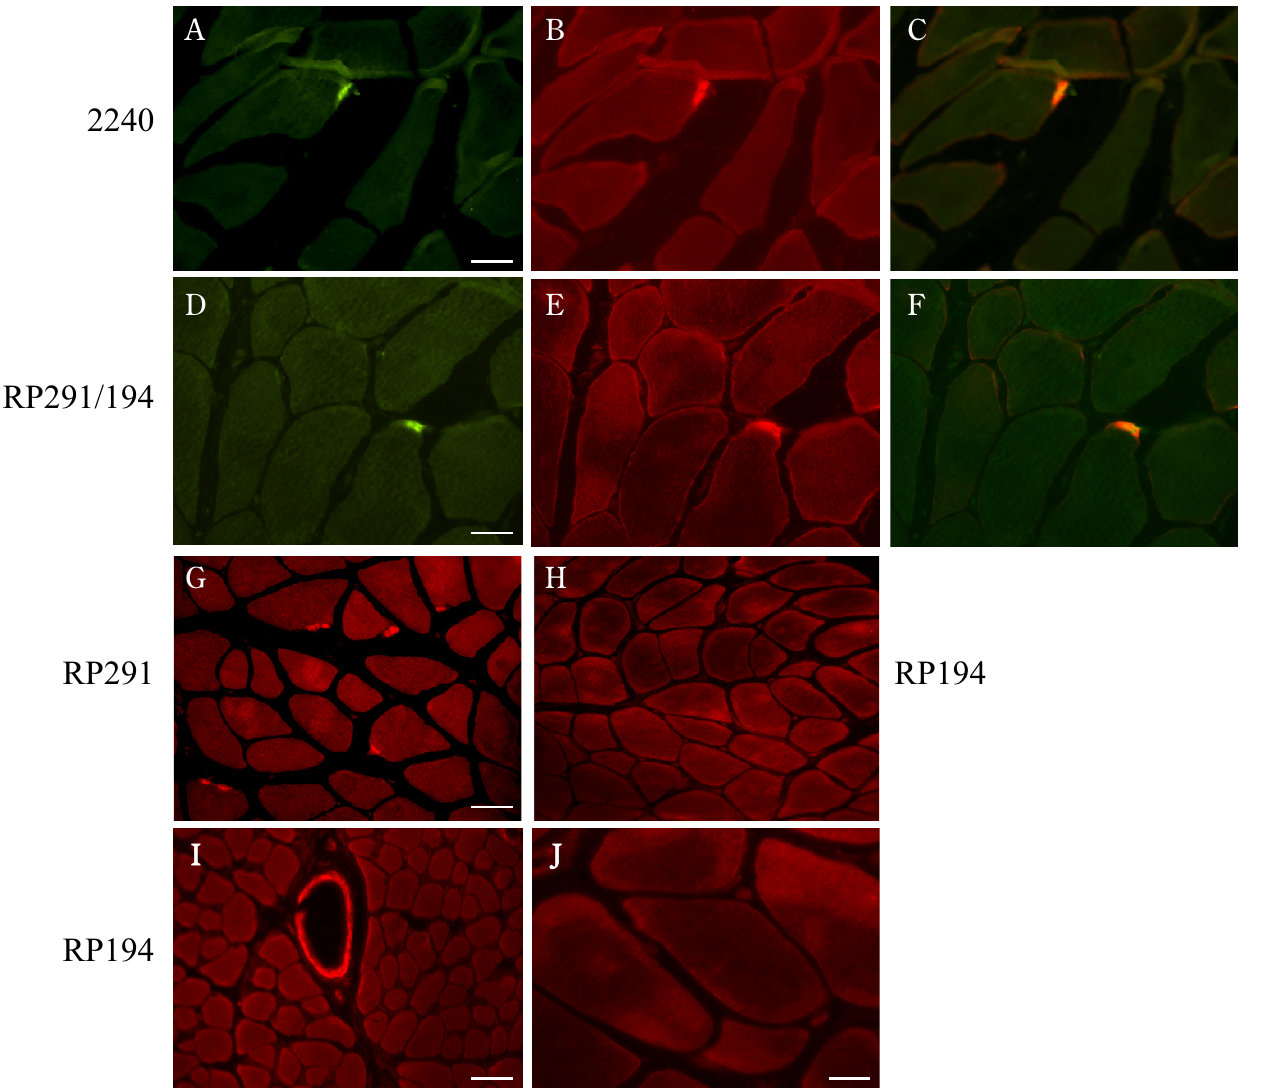
Figure 2 Immunolocalization of CAR to the neuromuscular junction in human skeletal muscle . Frozen sections of human muscle were incubated with Alexa Fluor-conjugated α -bungarotoxin and antibodies to CAR as described in Materials and Methods. Panels A and D show α -bungarotoxin staining of acetylcholine receptors at neuromuscular junctions (green). Panel B shows immunofluorescent staining of the section in panel A with a polyclonal antibody (ab 2240) to the extracellular domain of CAR (red). Panel E shows immunofluorescent staining of the section in panel D with a mixture of the isoform-specific C- terminal antibodies RP194 and RP 291 (red). Panel C is a merge of panels A and B . Panel F is a merge of panels D and E . These merges [ C, F ] show that CAR colocalizes with α -bungarotoxin at neuromuscular junctions (in yellow). Of the two C- terminal antibodies, only RP291 ( G ) demonstrates the typical neuromuscular junction staining while signal is absent when sec- tions are incubated under similar conditions with RP194 ( H ) although RP194 does label blood vessels ( I ). Sections incubated with secondary antibody alone did not reveal any signals ( J ). Bar = 25 µ m (A, D); 50 µ m (G,